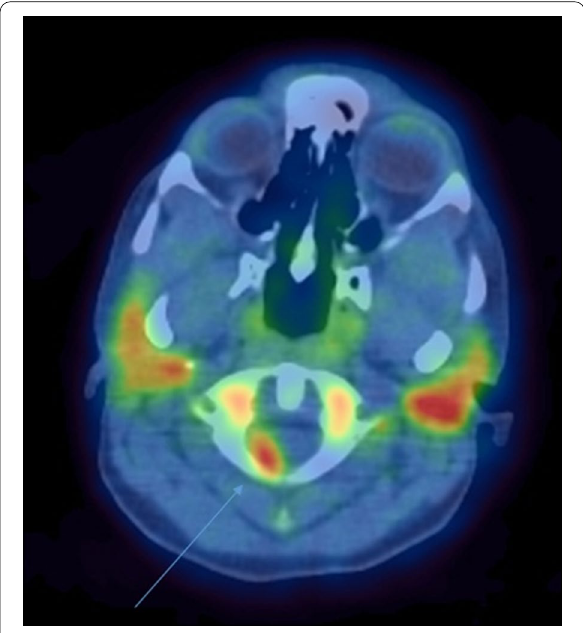
Table 4 Summary of cardiac PET findings in subjects